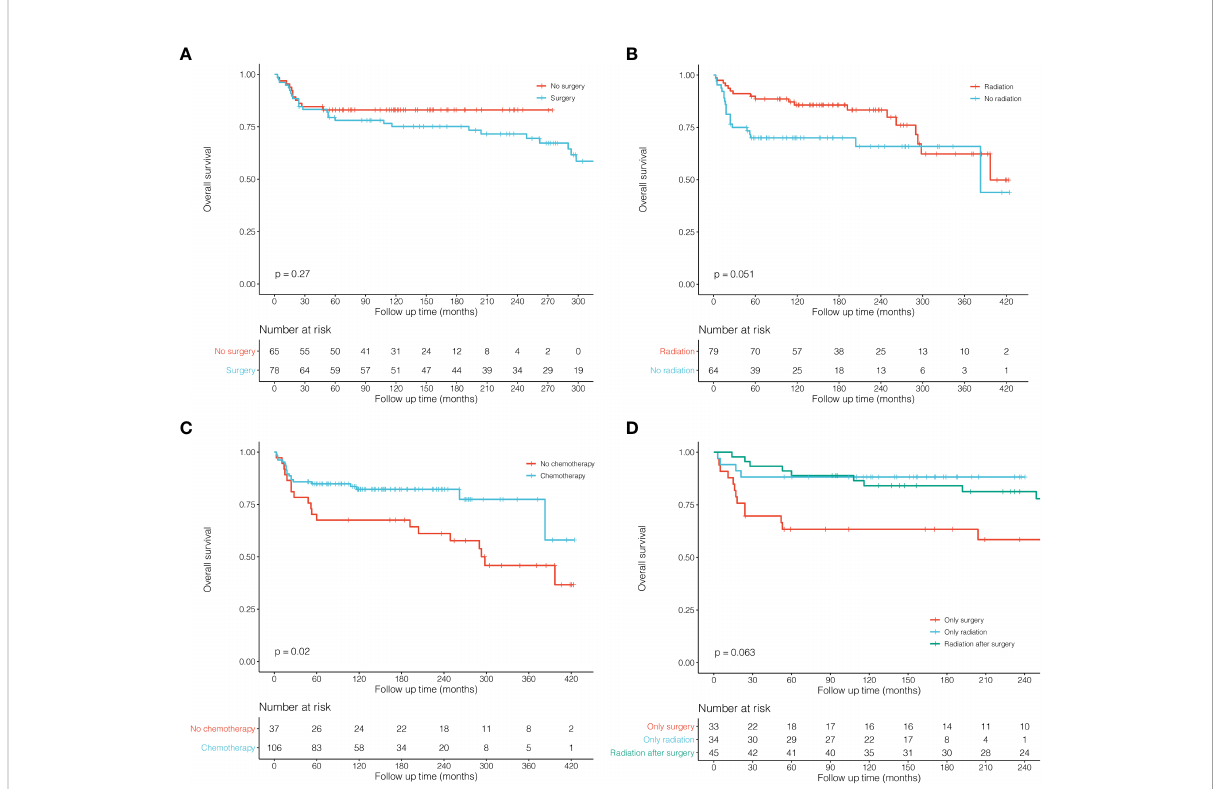
FIGURE 3 Kaplan – Meier survival curves and log-rank tests for patients with thymic lymphoma (Ann Arbor stage I and II) in different subgroups. (A) KM survival curves of patients with thymic lymphoma comparing No surgery and Surgery. (B) KM survival curves of patients with thymic lymphoma comparing No radiation and Radiation. (C) KM survival curves of patients with thymic lymphoma comparing No chemotherapy and Chemotherapy. (D) KM survival curves of patients with thymic lymphoma comparing Only surgery, Only radiation and Radiation after